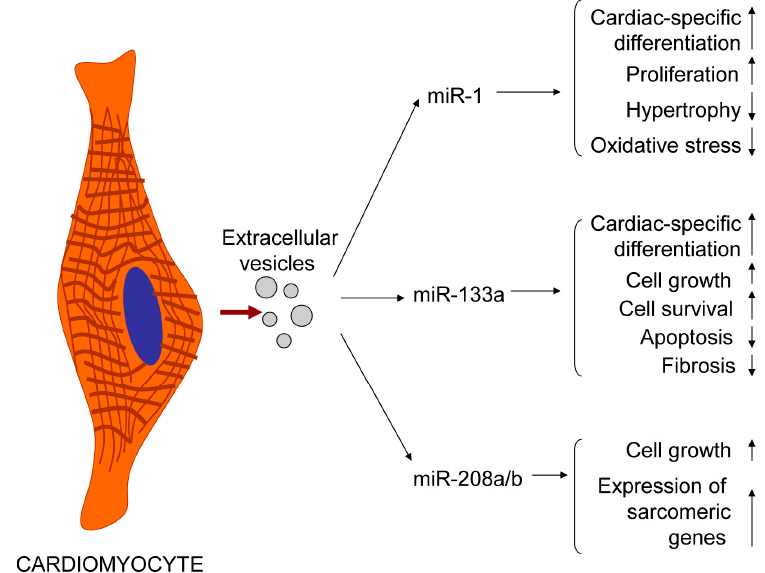
Figure 1. Cardioprotective properties of exosomal cardiac-specific microRNAs released by injured cardiomyocytes in acute myocardial infarction on cardiac muscle cells and resident cardiac stem/progenitor cells.